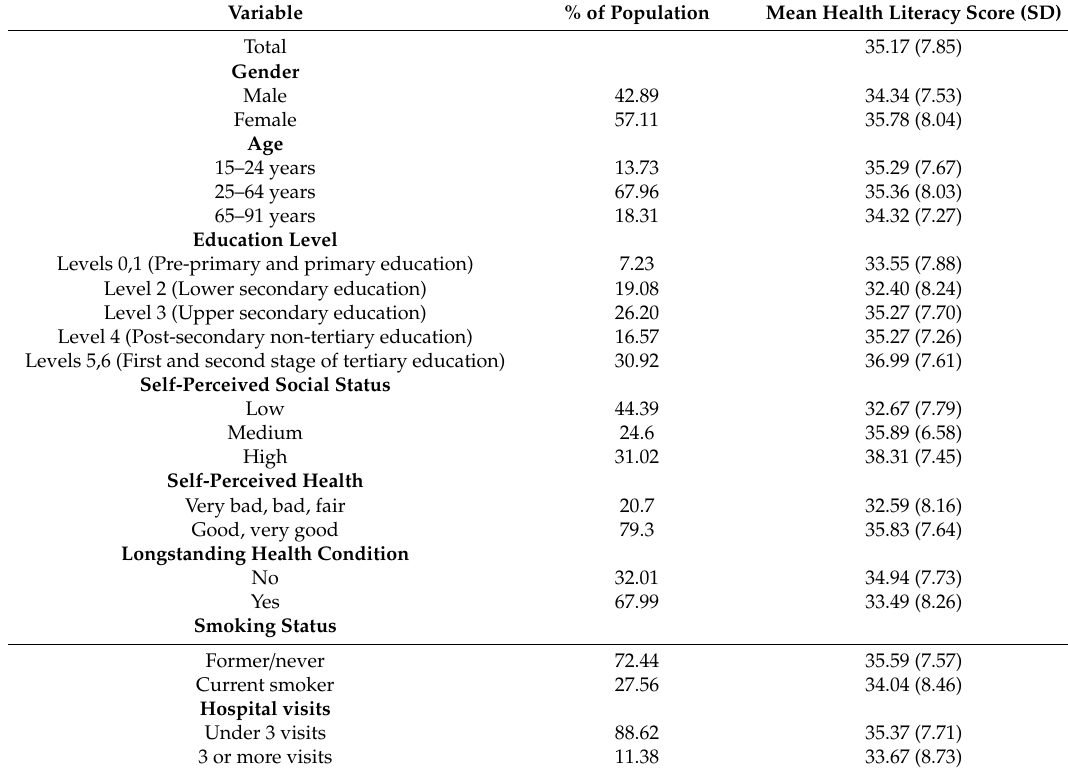
Table 2. Sample characteristics and mean health literacy score by